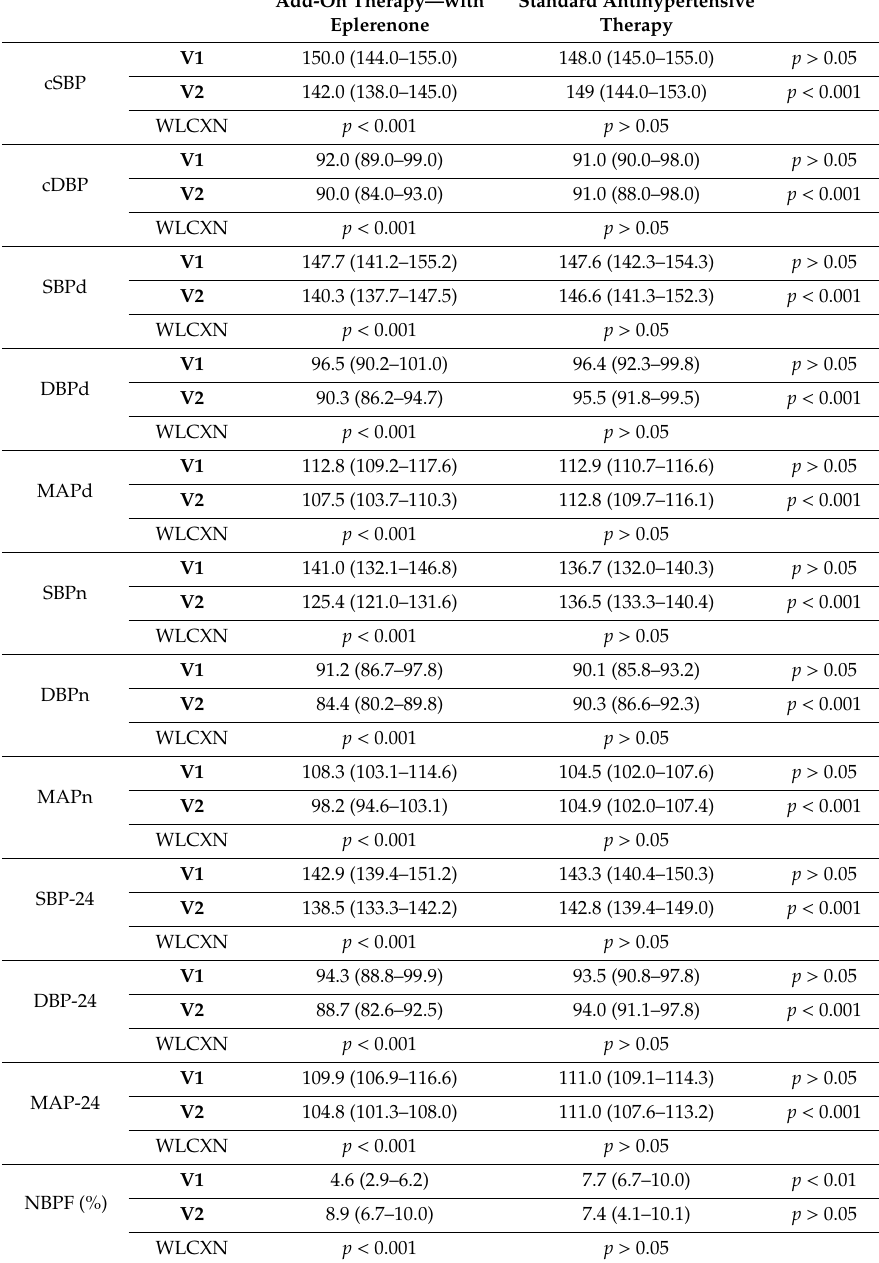
Table 2. The BP parameters (mm Hg) observed for patients assigned to add-on treatment with eplerenone (50 mg / day) and standard hypertensive treatment before (V1) and after 6 months (V2). All values are reported as median (interquartile range). The statistical comparison of parameters before (V1) and after treatment (V2) were conducted with Wilcoxon test (WLCXN) while the eplerenone versus standard hypertensive treatment comparison was conducted with Mann–Whitney U test (MW- U